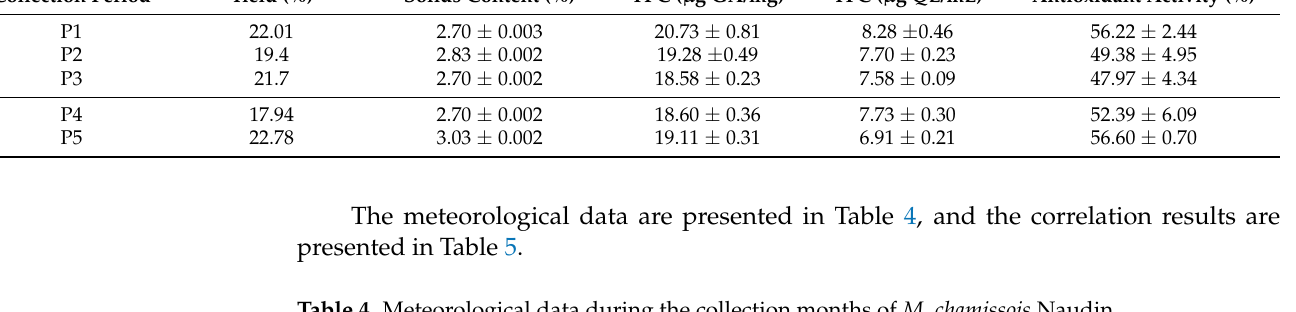
Table 4. Meteorological data during the collection months of M. chamissois Naudin.